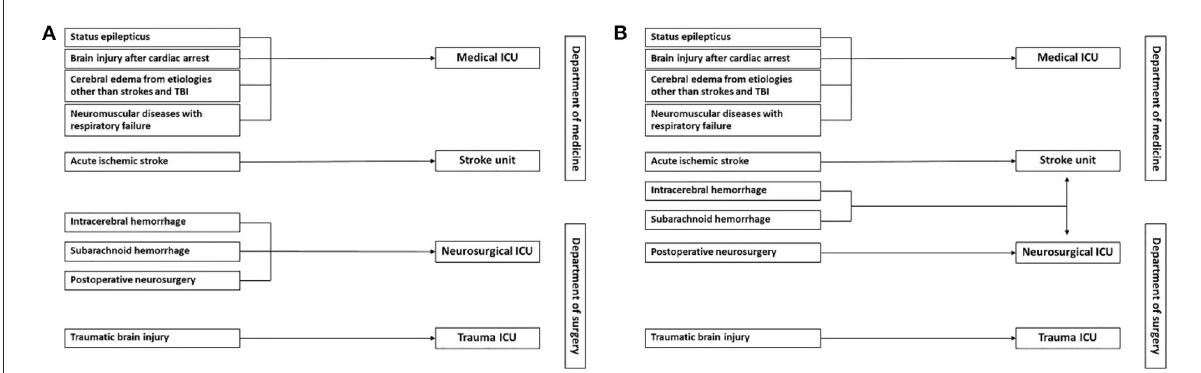
FIGURE1 Workflow of neurocritical care patients in our institution before (A) and after (B) the operation of a new comprehensive stroke unit. (A) Patients with acute ischemic stroke are admitted to the stroke unit. Patients who receive neurosurgical procedures or have intracerebral or subarachnoid hemorrhage are admitted to the neurosurgical ICU. Depending on their trauma severity, patients with traumatic brain injury may be admitted to the trauma ICU or neurosurgical ICU. Patients with other life-threatening neurologic diseases, including status epilepticus, brain injury after cardiac arrest, cerebral edema from acute liver failure or central nervous system infection, and neuromuscular diseases with respiratory failure are admitted to the medical ICU. (B) More patients with intracerebral and subarachnoid hemorrhage will be admitted to the comprehensive stroke unit when it starts to